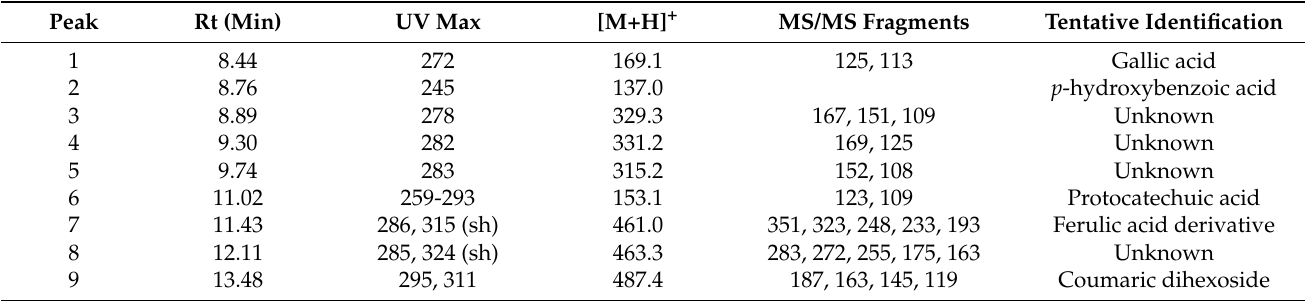
Figure 2. Chromatogram (registered at 280 nm) obtained in the analysis of phenolic compounds of coma ( S. lanoginosum ). Table 3. Tentative identification of phenolic compounds of S. lanoginosum fruit extract by HPLC-DAD electrospray ionization